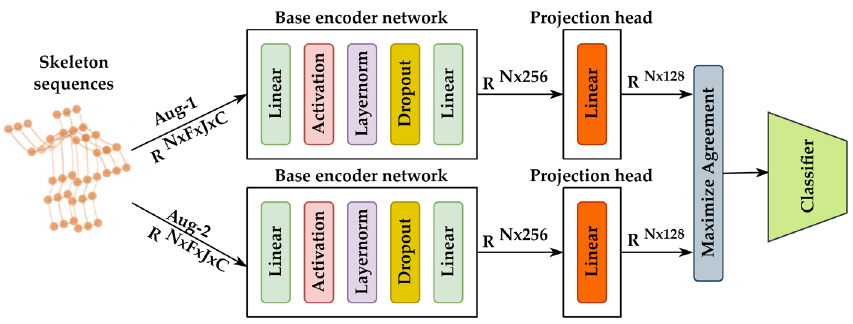
Figure 1. An overlook of the ConMLP framework. N denotes the mini-batch size; F denotes the number of frames in a skeleton sequence; J denotes the number of joints; C denotes the 3D coordi- nates.